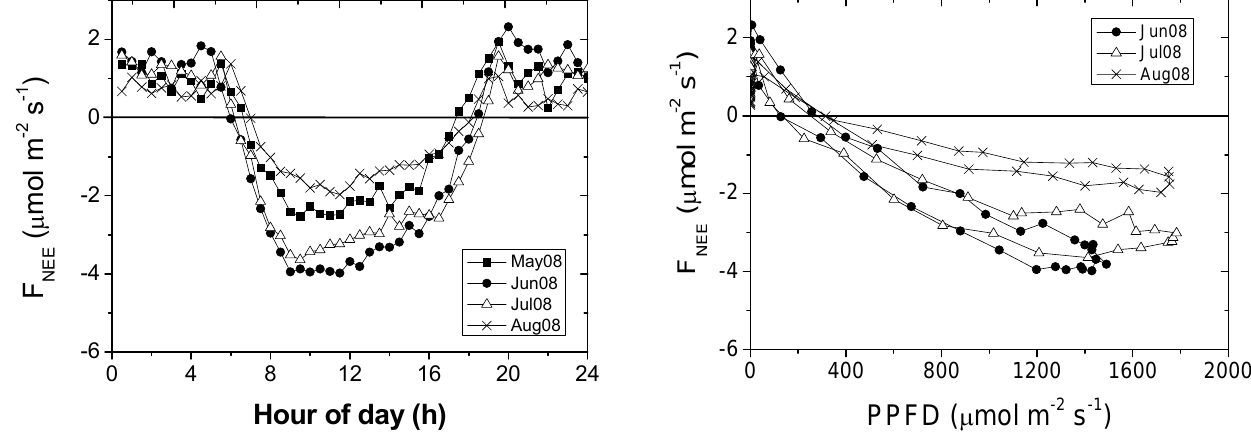
Fig. 4b. Mean diurnal NEE flux during May, June, July and Au- Figure 4b. Mean diurnal NEE flux during May, June, July and August 2008 in the gust 2008 in the alpine Mediterranean shrubland located in Sierra alpine Mediterranean shrubland located in Sierra Nevada mountain range. Nevada mountain range.